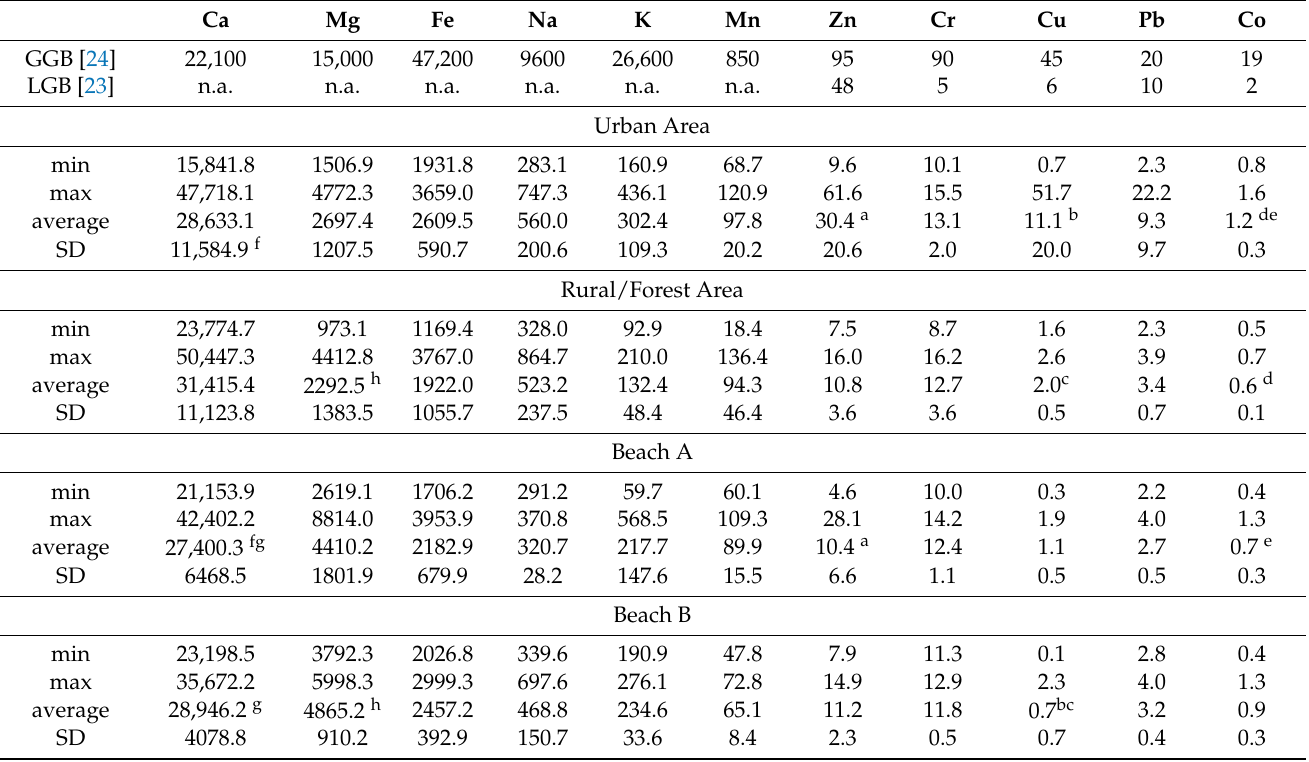
Table 3. Descriptive statistics of metal concentrations in lake sediments including catchment land-use pattern (urbanized, agricultural and forest areas,